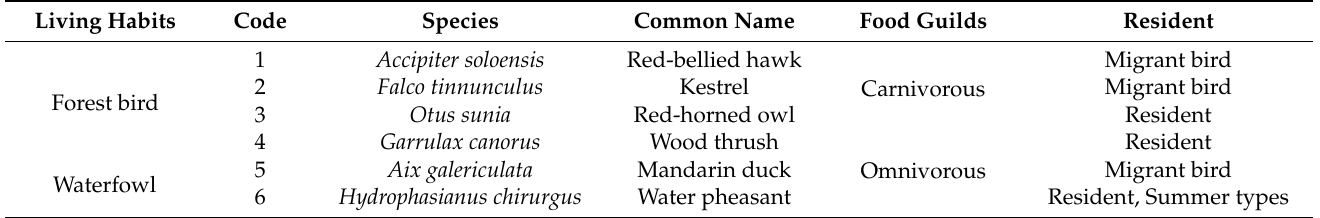
Figure 1. Location of the experimental area and its surroundings. Table 1. Bird species selected for the simulation of the habitat network of Nanjing’s main urban